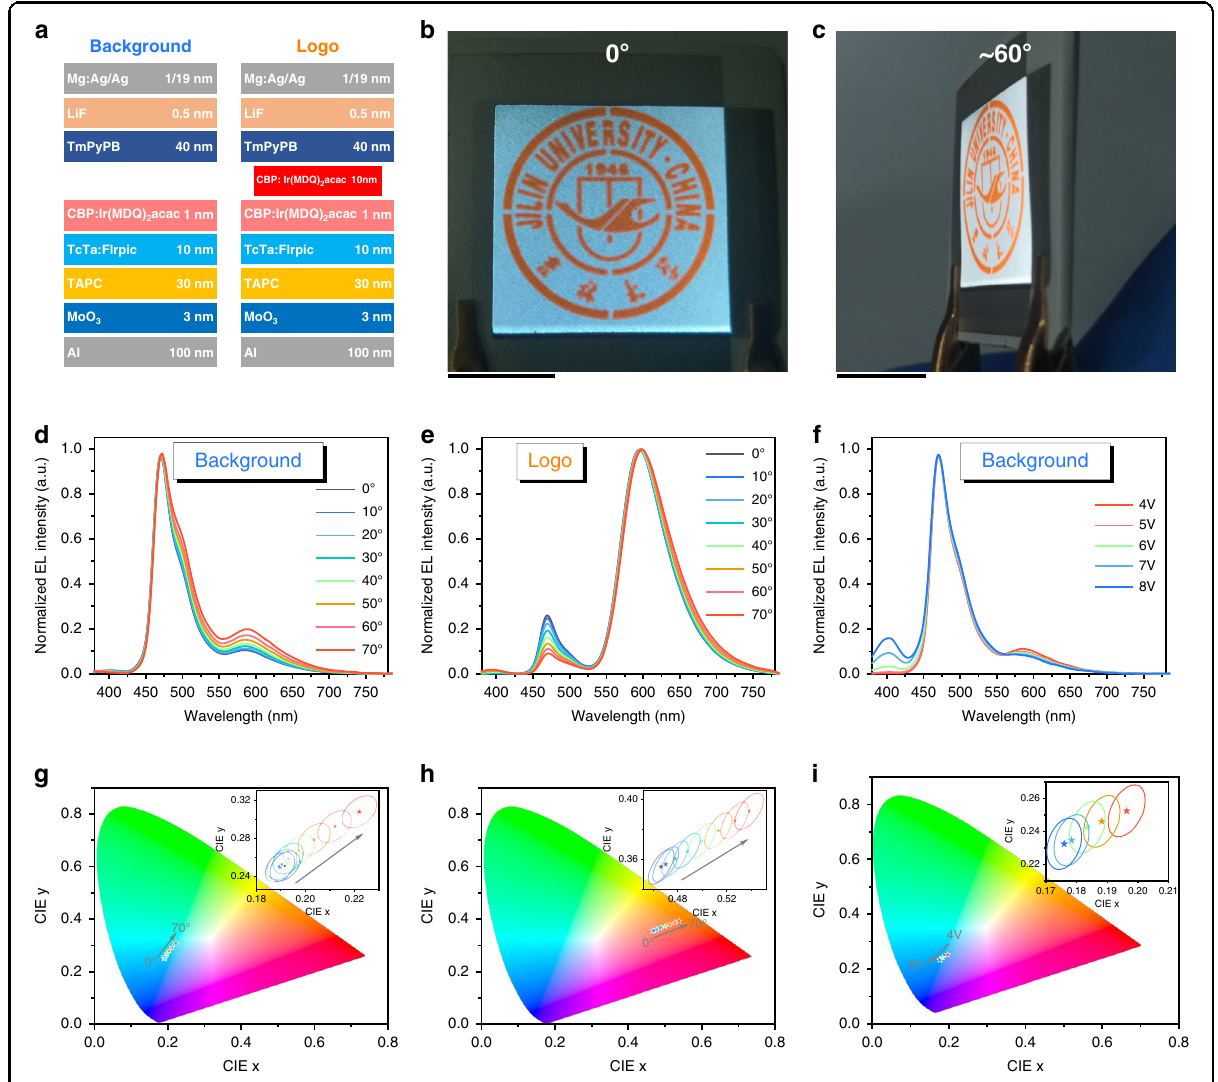
Fig. 5 Color-shift characteristics of white and orange FAC device. a Details of the structures of the background and logo areas of the white and orange FAC device. b Front-view image of the white and orange FAC device in response to electricity stimuli (5 V), and ( c ) its image at a viewing angle of about 60°. d Normalized spectra of the device “ background ” at different viewing angles. e Normalized spectra of the device “ logo ” at different viewing angles. f Normalized spectra of the device “ background ” at different bias voltages. g CIE coordinates and their 5-step MacAdam ellipses of the device “ background ” at different viewing angles. h CIE coordinates and their 5-step MacAdam ellipses of the device “ logo ” at different viewing angles. i CIE coordinates and their 5-step MacAdam ellipses of the device “ background ” at different bias voltages. Black scale bar of each fi gure represents the length of 1